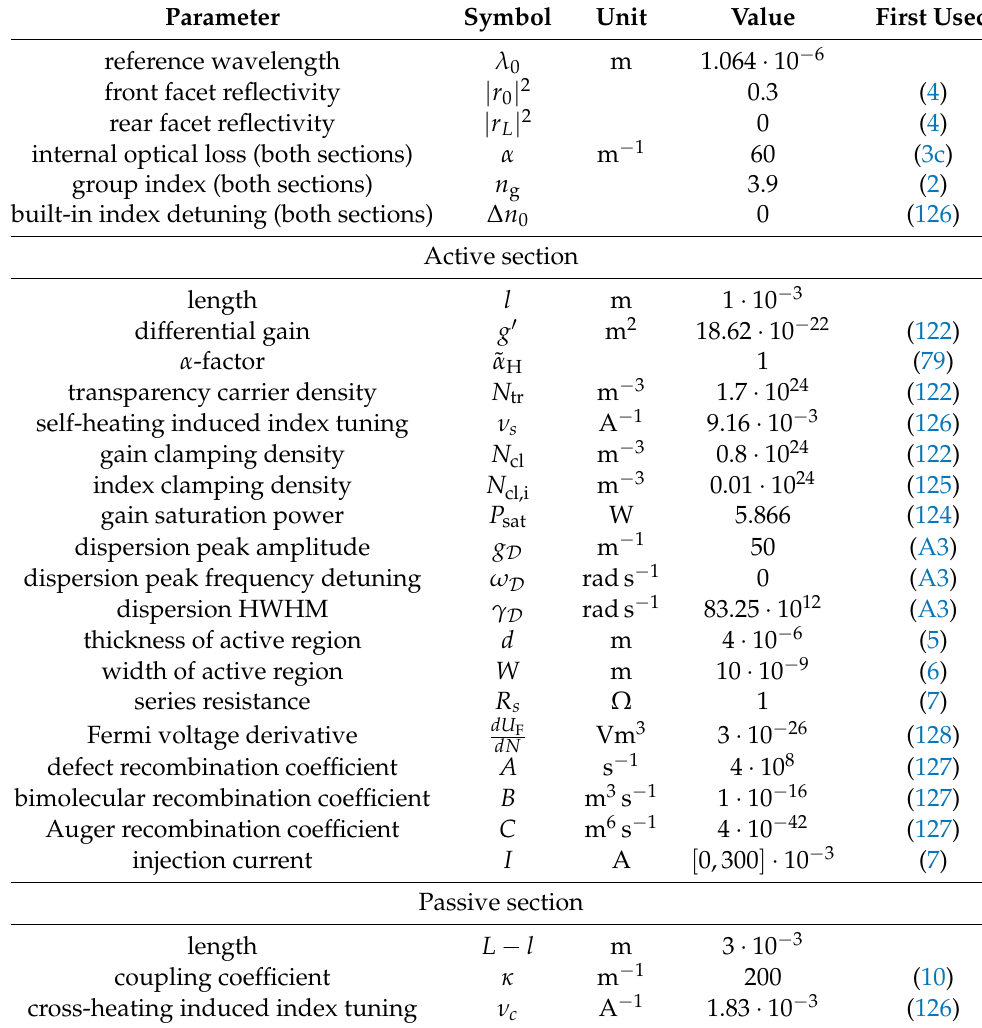
Table 1. Parameters of the simulated DBR